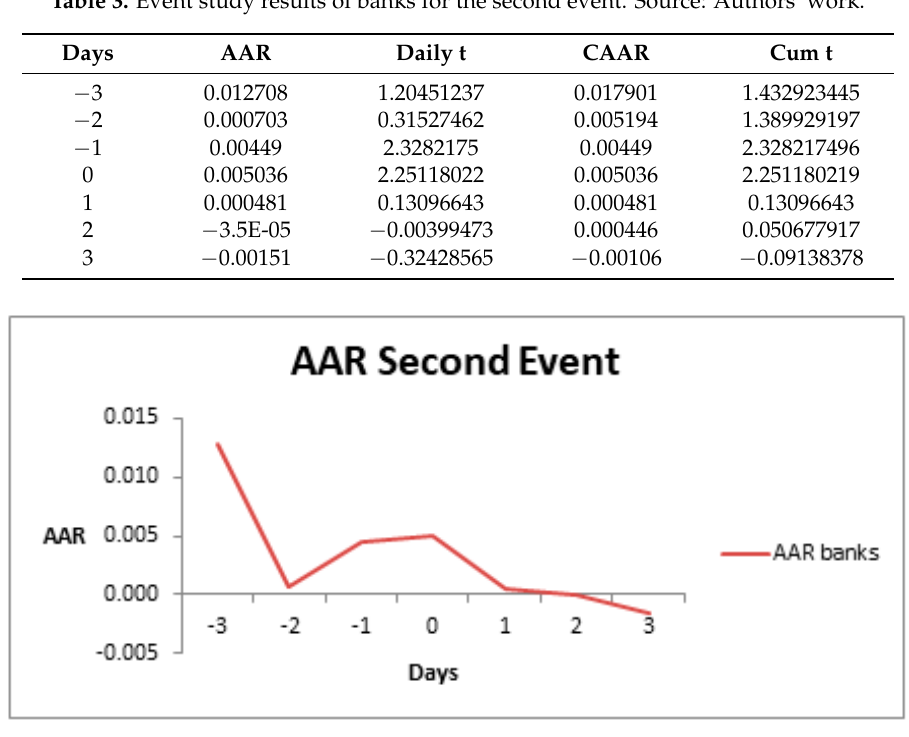
Figure 5. Average Abnormal Return (AAR) for banks. Source: Authors’ work.